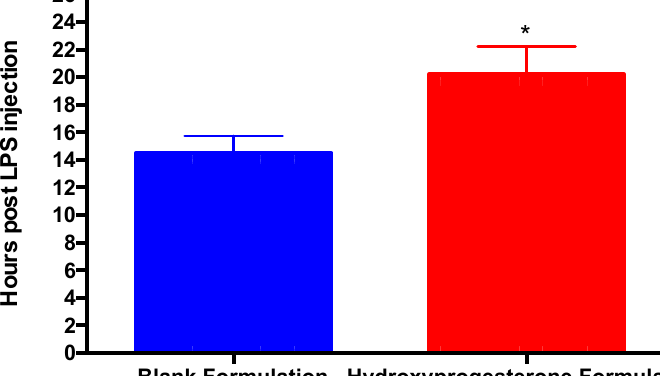
Figure 6. 17P SNEDDS significantly increases the time to delivery compared to the Blank formulation group. Treatment with the 17P formulation significantly increased the hours post LPS injection to delivery. For the purpose of statistical analysis, a delivery time of 24 h was assumed for mice that did not deliver during the experiment. * p < 0.05, Student’s t test.